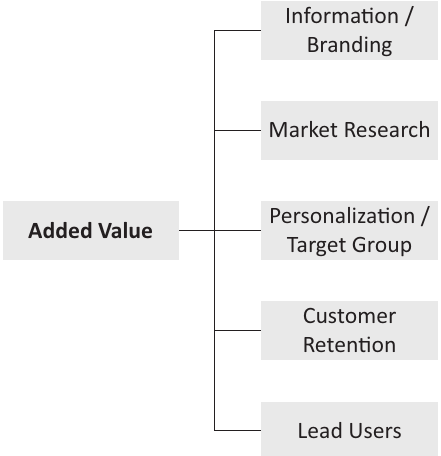
Figure 2. Advertisers’ expectations towards the added value of marketing within